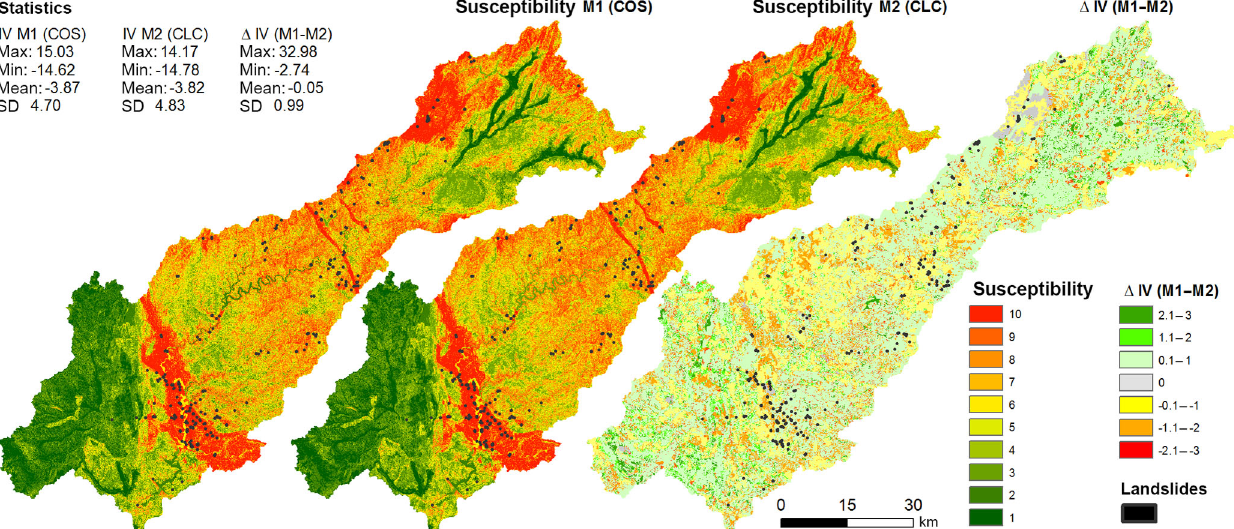
Figure 5. Landslide susceptibility (IV represented from the highest – red – to the lowest susceptibility – green): the map of Susceptibility M1 represent the results obtained with model 1 (performed with COS data) – LSM1; the map Susceptibility M2 represent the results obtained with model 2 (performed with CLC data) – LSM2. The map on the right is the variation between LSM1 and LSM2.